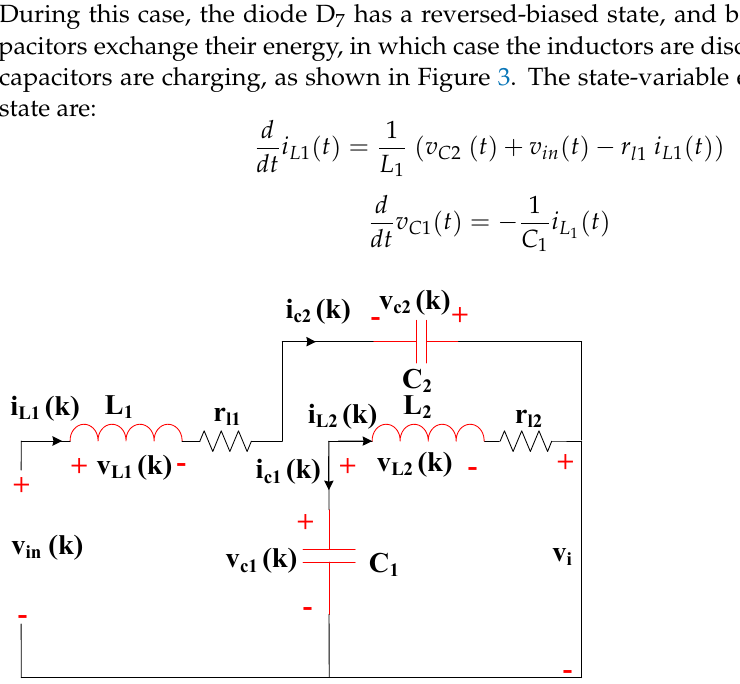
Figure 3. Equivalent circuit of qZSI in the shoot-through